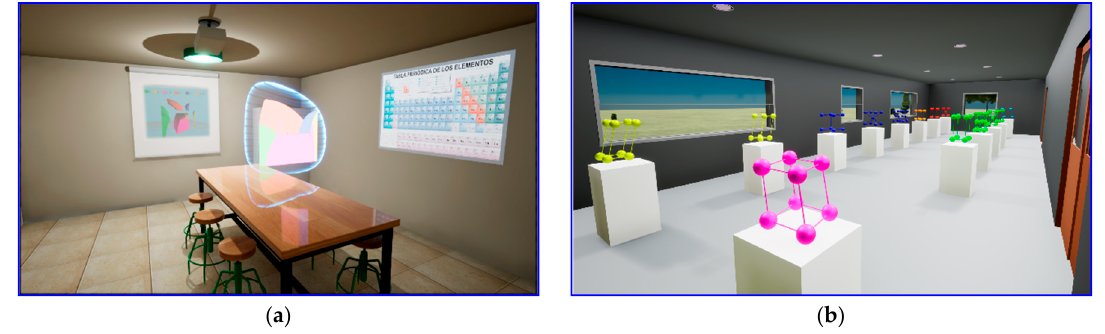
Figure 4. Screenshots of the VRLEs subsequently developed (VRLEs-2): ( a ) VRLE-2 system dedicated to TPD studies and ( b ) VRLE-2 system designed for CL investigations.